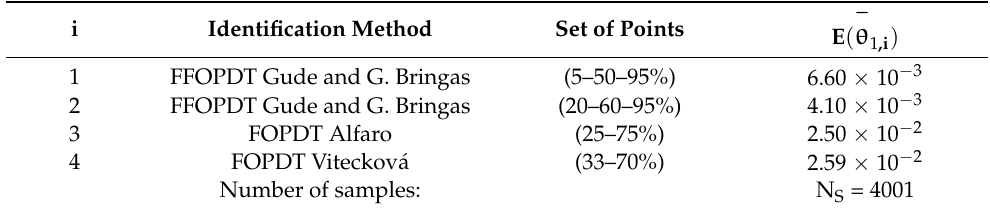
Table 8. Model performance indexes obtained for the considered identification methods for FFOPDT and FOPDT models.